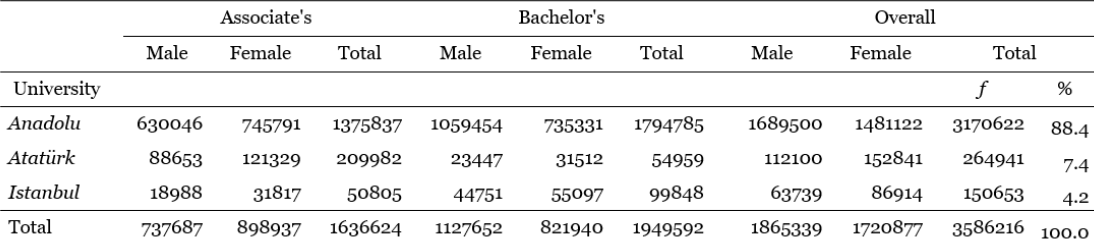
Open Universities in Turkey and Their Student Numbers by 2018